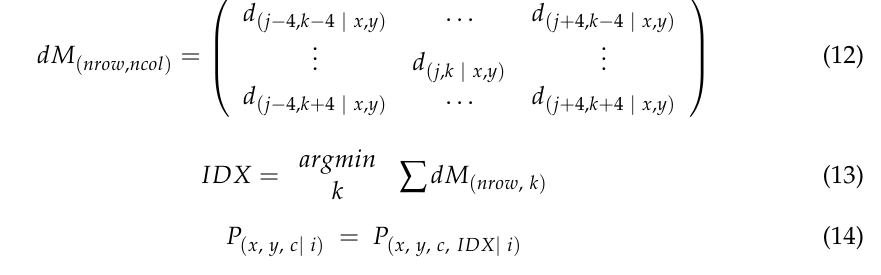
repeat steps 4 to 13 to calculate maximum specular reflection in suppressed image of transparent object from already suppressed sub-apertures